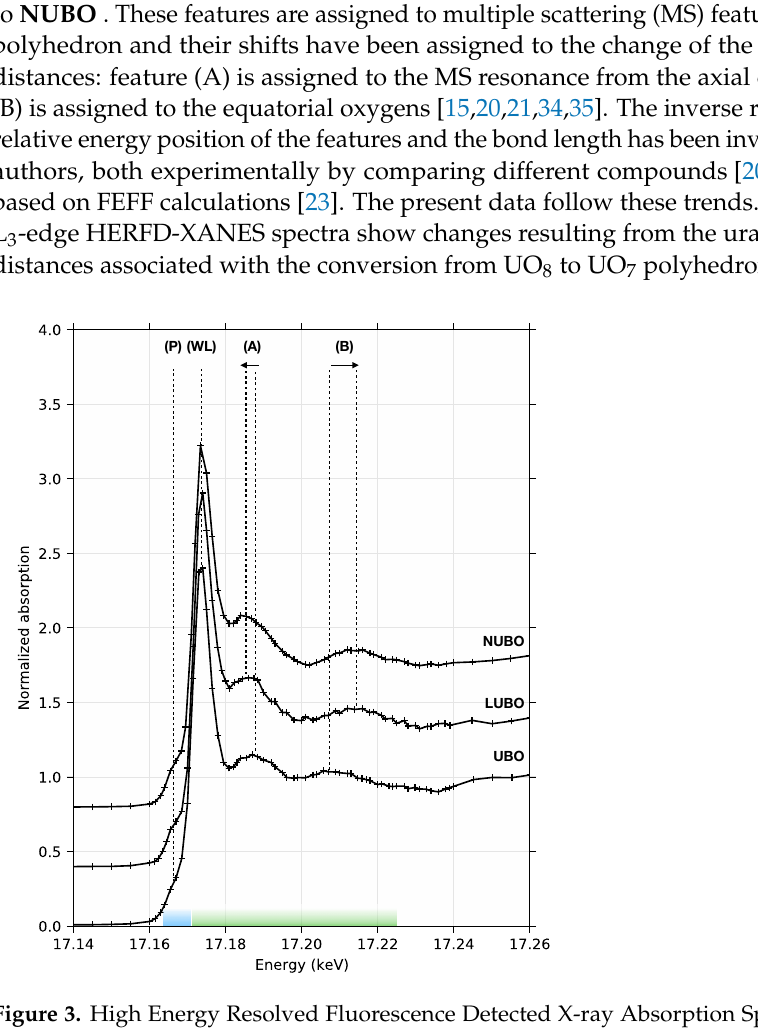
Figure 3. High Energy Resolved Fluorescence Detected X-ray Absorption Spectroscopy (HERFD- XAS) spectra at the U L 3 -edge, from UBO (bottom) to NUBO